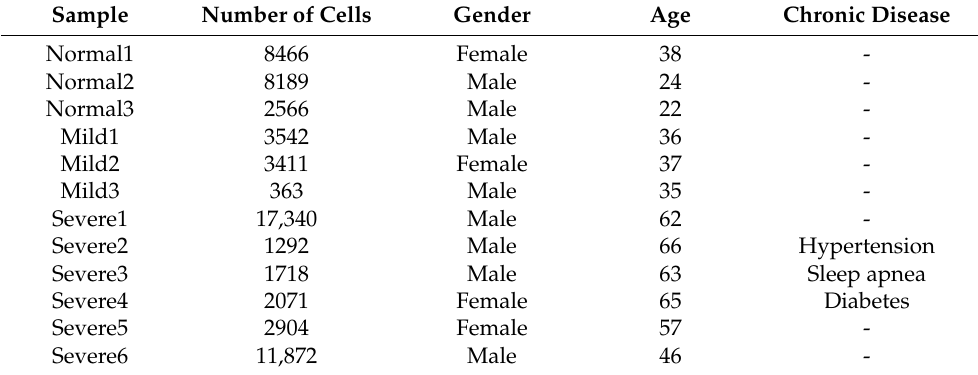
Table 1. Demographics of patients and number of cells after filtering. The average age of 12 patients is 45.91 with a standard deviation of